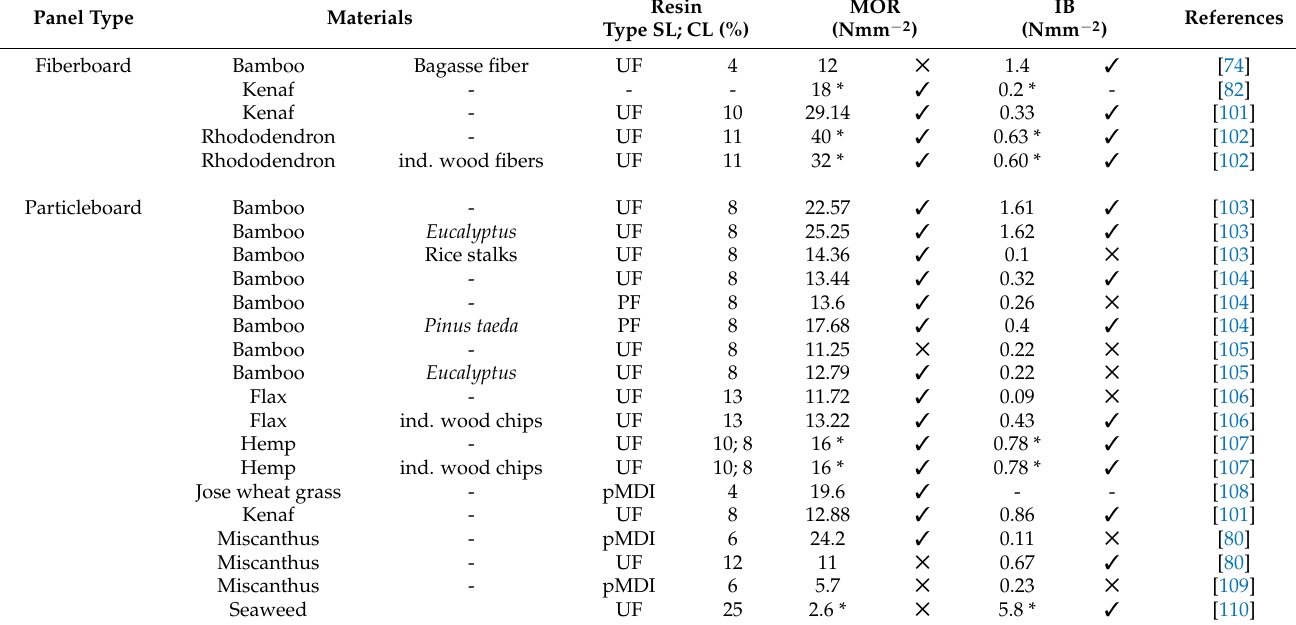
Table 5. NWLM used for panel production with information on whether MOR and IB meet ( (cid:51) ) or not ( (cid:53) ) the standard requirements (fiberboard EN 622-3:2004; particleboard EN 312:2003).